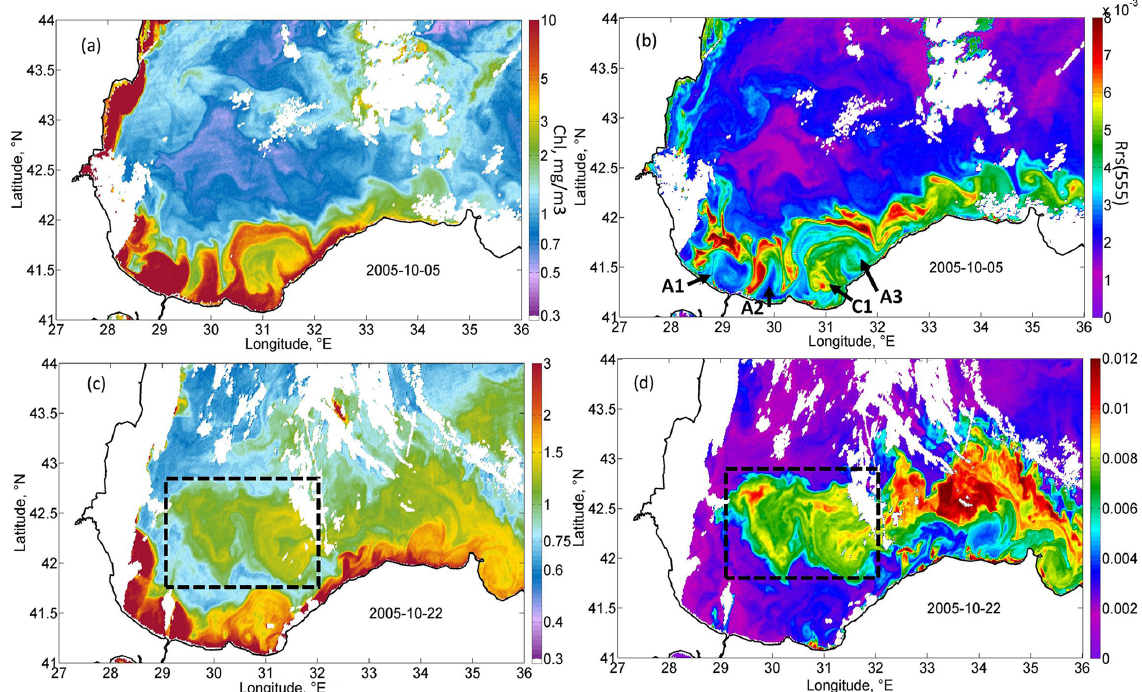
Figure 5. Magnified daily MODIS maps demonstrating the two stages of coccolithophore blooms development. MODIS daily map of Chl (a) and R rs (b) on 5 October 2005, demonstrating the initial rise in R rs on the offshore periphery of the Danube plume. MODIS daily map of Chl (c) and R rs (d) on 22 October 2005, demonstrating the rise in R rs in the western gyre of the Black Sea (black dashed